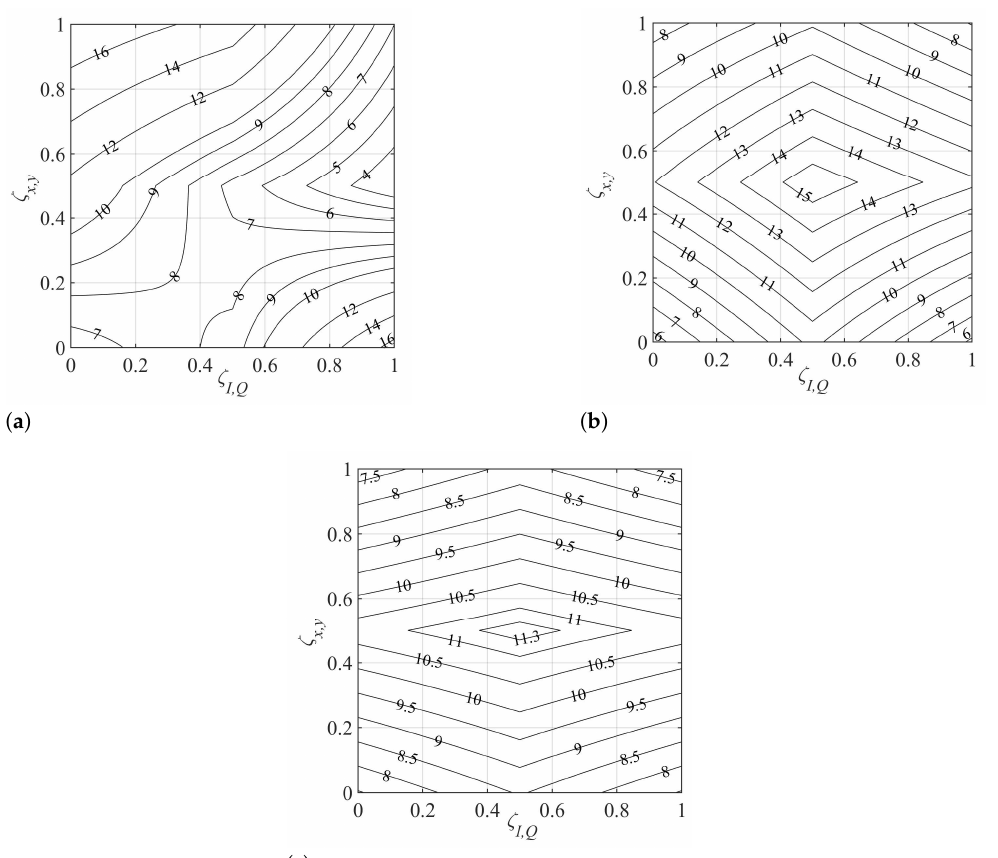
Figure 6. Unbalancing parameter for different pairs ( L B , L C ) and homogeneous WC-MCF (cid:0) ∆ (cid:1) β c, mn = 0rad·m − 1 : ( a ) L B = 10m, L C = 10m; ( b ) L B = 10m, L C = 1m; and ( c ) L B = 0.1m, L C =